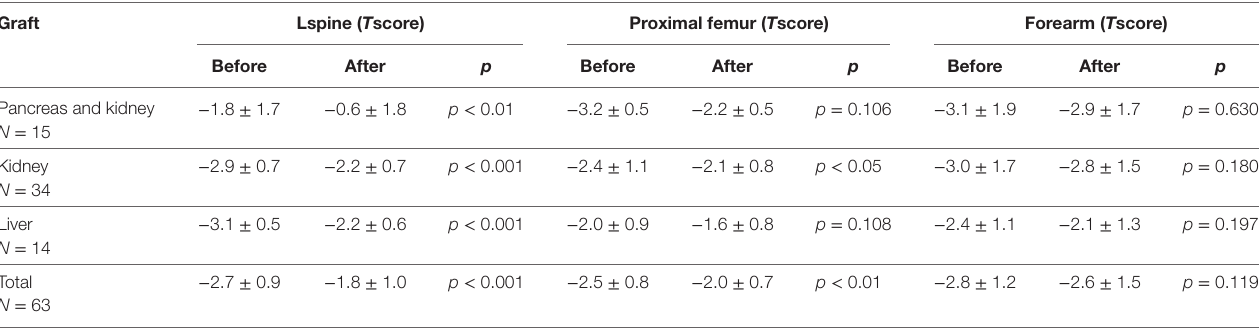
Table 4 | Bone mineral density changes (%) in L spine, hips, and forearm in osteoporotic sites and all patients. graft Tx Pancreas and kidney